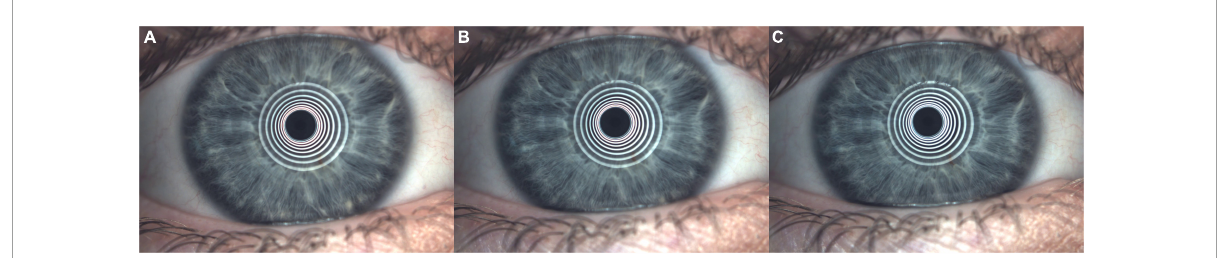
FIGURE5 Non-Invasive Break-Up Time (NIBUT). (A) Placid disk rings reflected on tear film just after initial double deliberate blinks. (B) First Placido rings deformation (difficult to see visually by a human) this moment automated establishes the first non-invasive break-up time (FNIBUT). (C) Mean and general Placido rings deformation (difficult to see visually by a human) this moment automated establishes the mean non-invasive break-up time (MNIBUT).